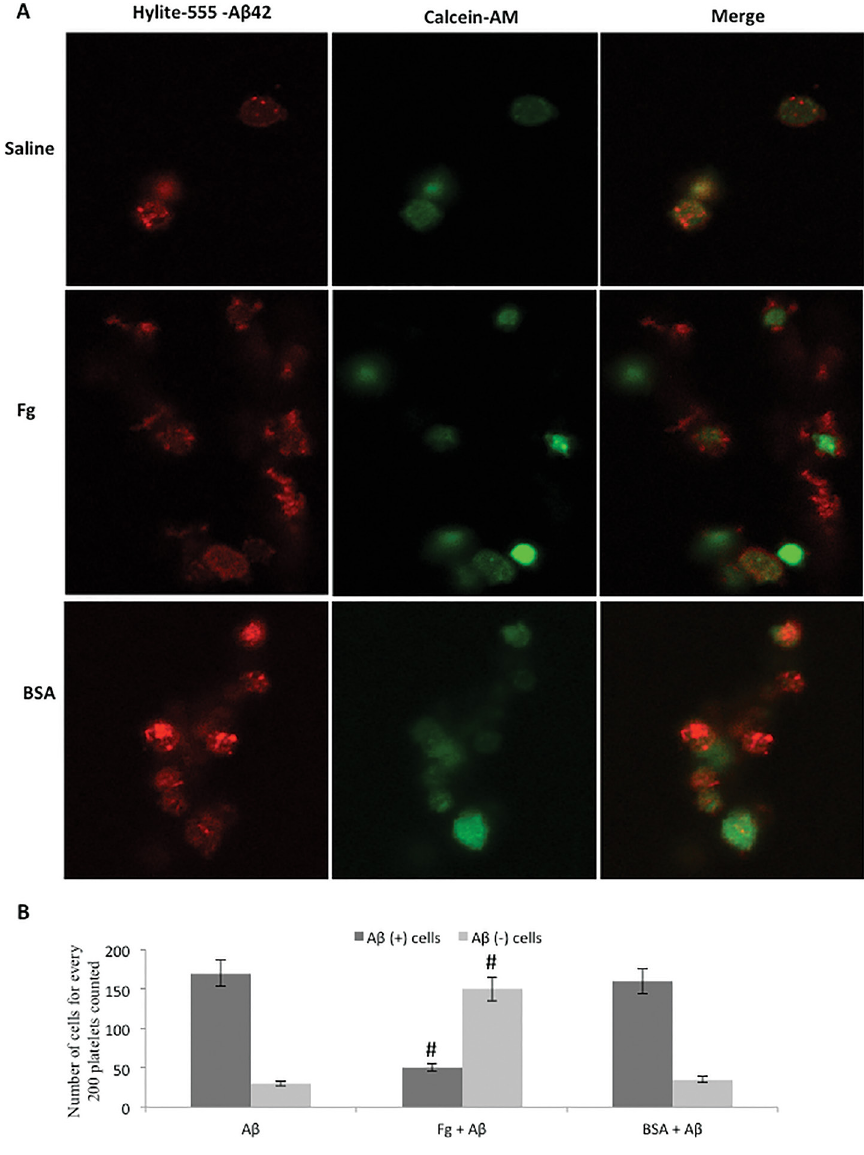
in human platelets. (A) Human platelets, fluores- 42 (red) and calcein/AM (green), were pretreated 42 for every 200 platelets 42 -treated cells in the absence of 42